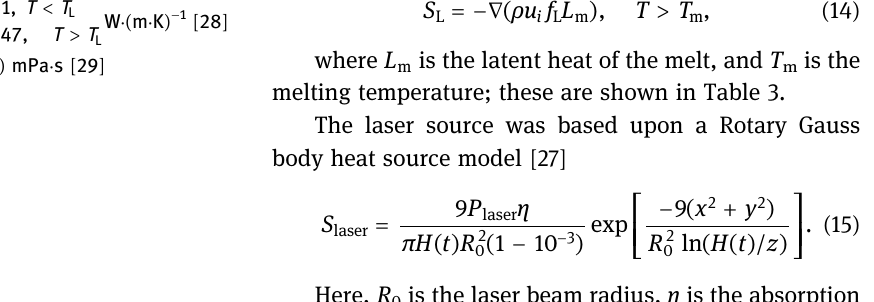
Table 3: Material parameters Properties of 2195 Al – Li alloys Density